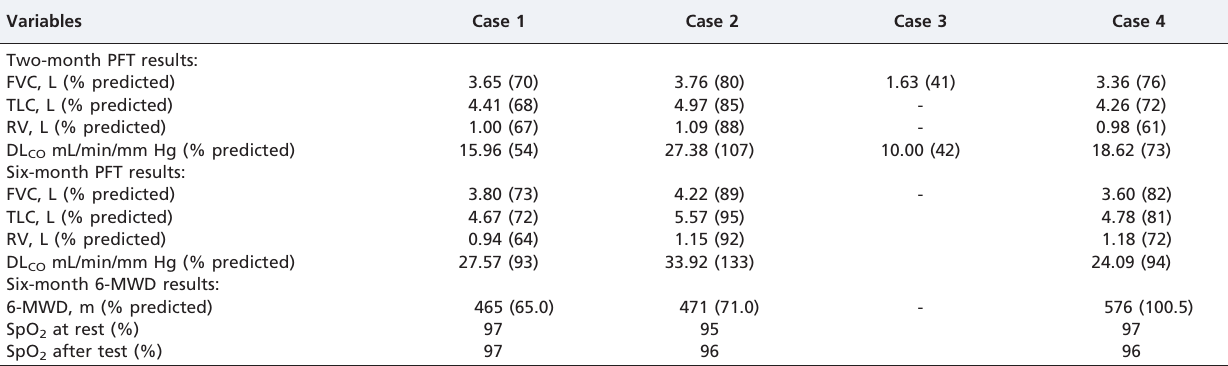
Table 2 - Sequential PFTs and 6-MWDs of patients with ARDS caused by influenza A (H1N1) virus included in this case